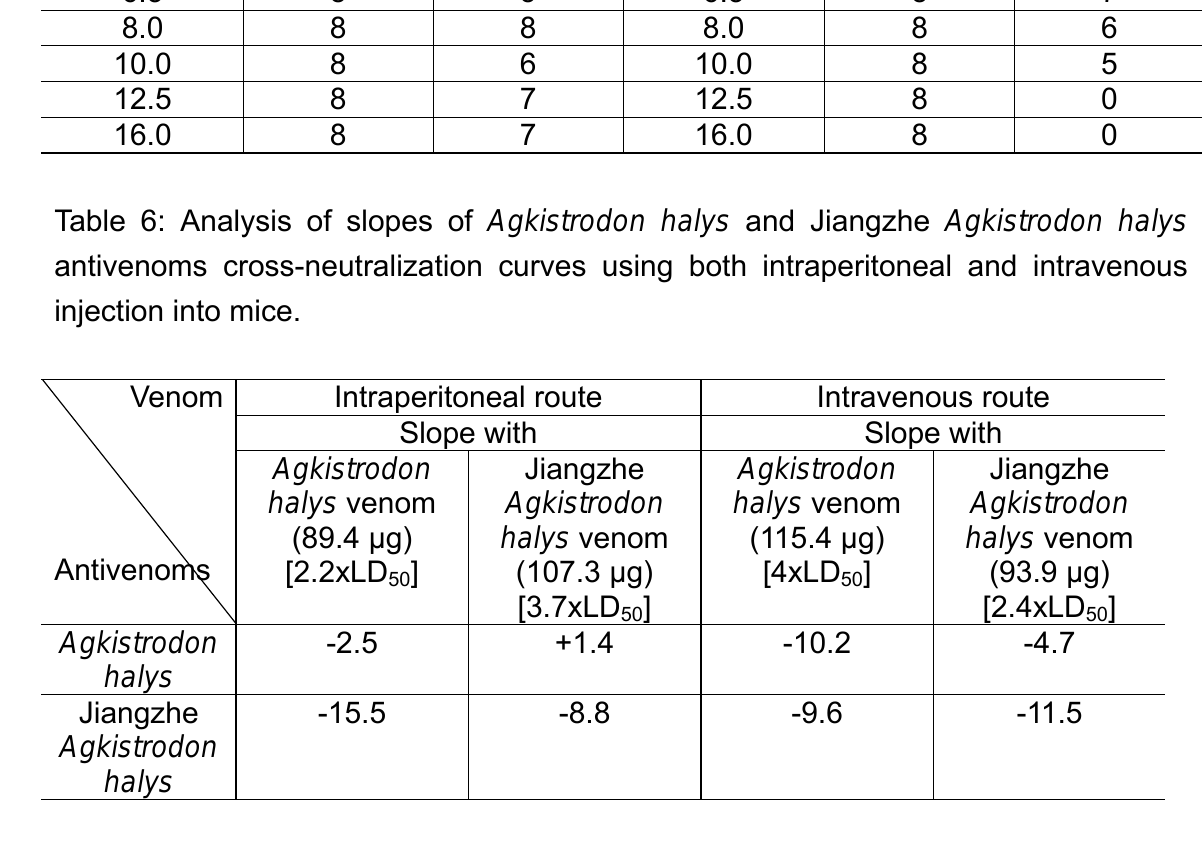
) of Agkistrodon halys and Jiangzhe 50